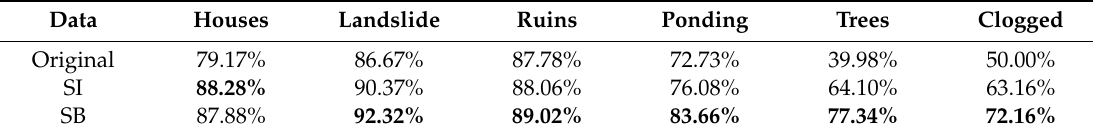
Table 8. F1 score results of the PEMSR model under various conditions. SI refers to the best F1 score results after the sample volume was increased, and SB refers to the F1 score results after the sample was balanced. The bold values are the best results among several experiments for each scene.